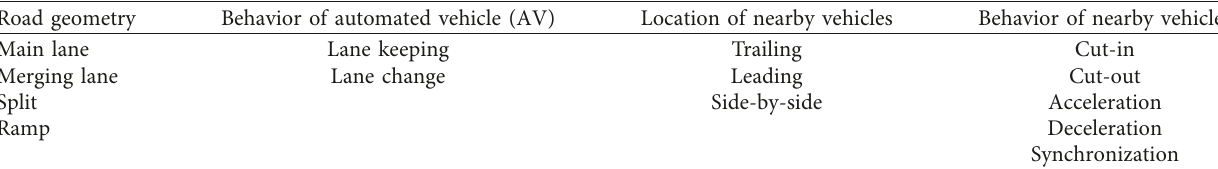
Figure 1: Typical traffic accident Table 1: Triggering conditions related to-traffic situations.